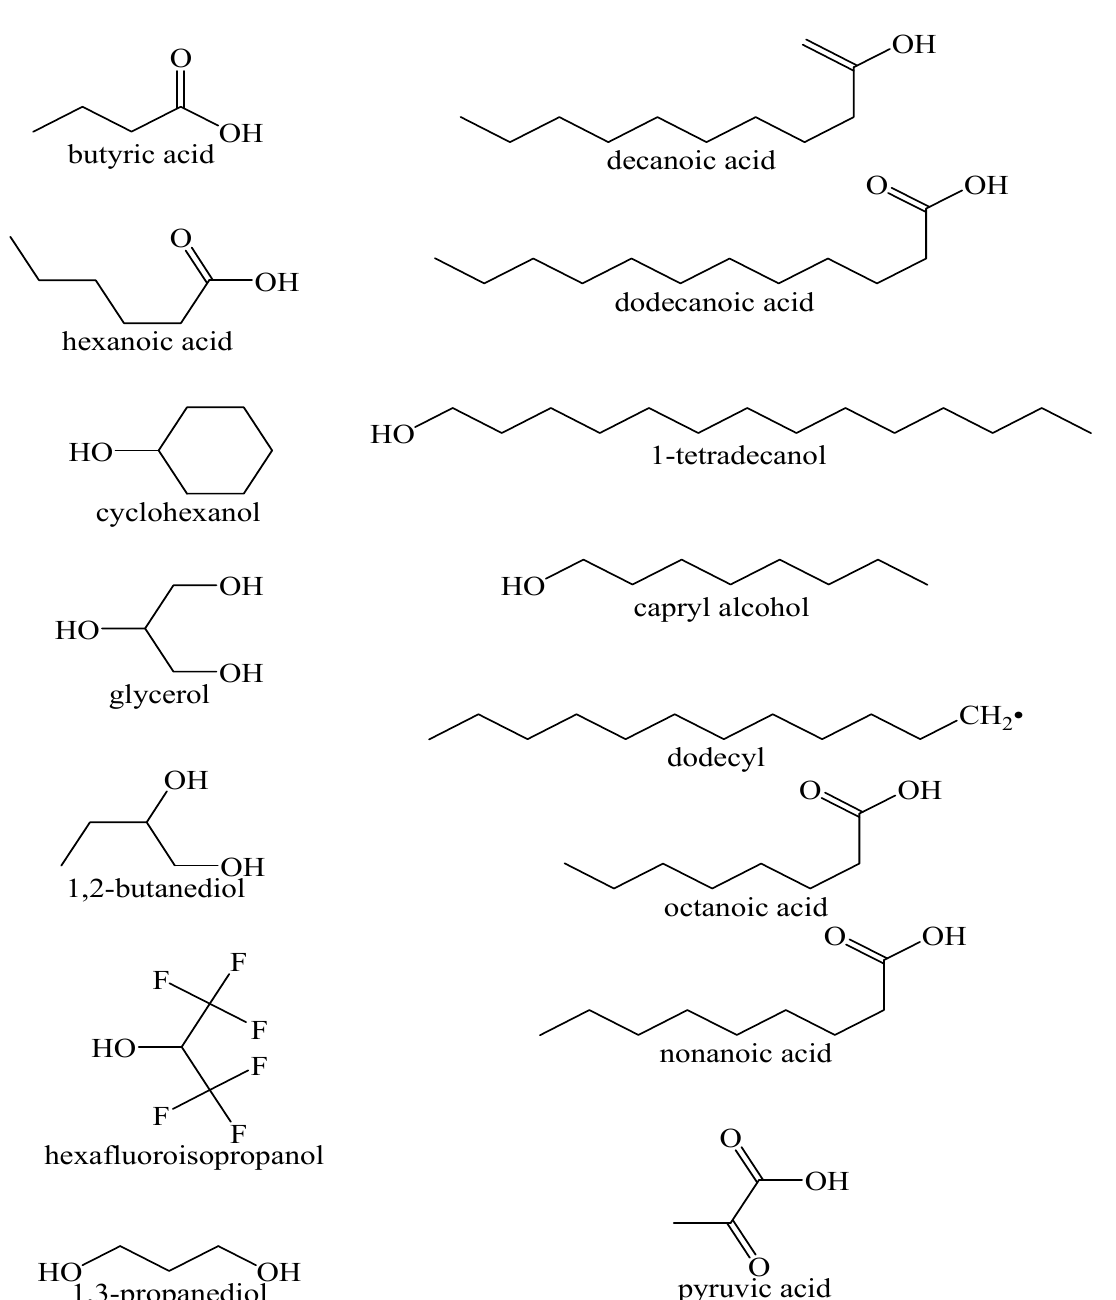
Figure 3. Common HBD used for HDES synthesis.